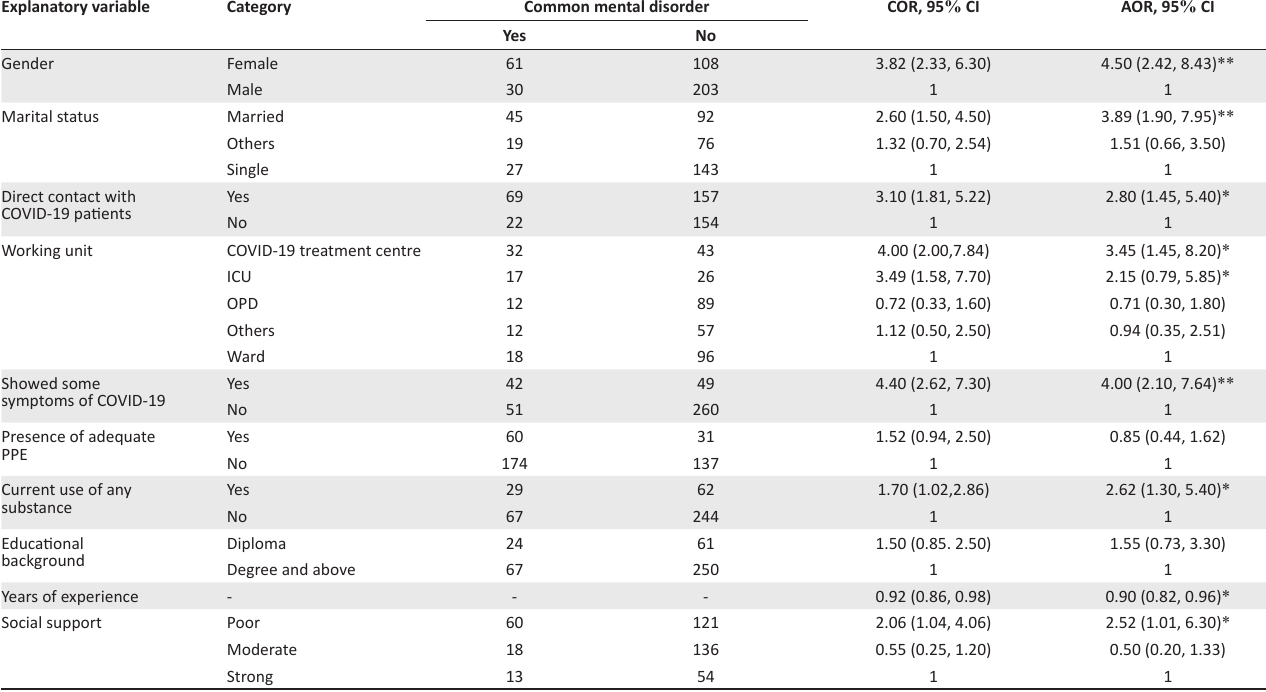
FIGURE 2: Prevalence of common mental disorder amongst frontline healthcare workers amidst COVID-19 pandemic in Ethiopia, 2021. TABLE 3: Factors associated with common mental disorders amongst frontline healthcare workers during COVID-19 pandemic in Ethiopia, 2021 ( n = 402). Explanatory